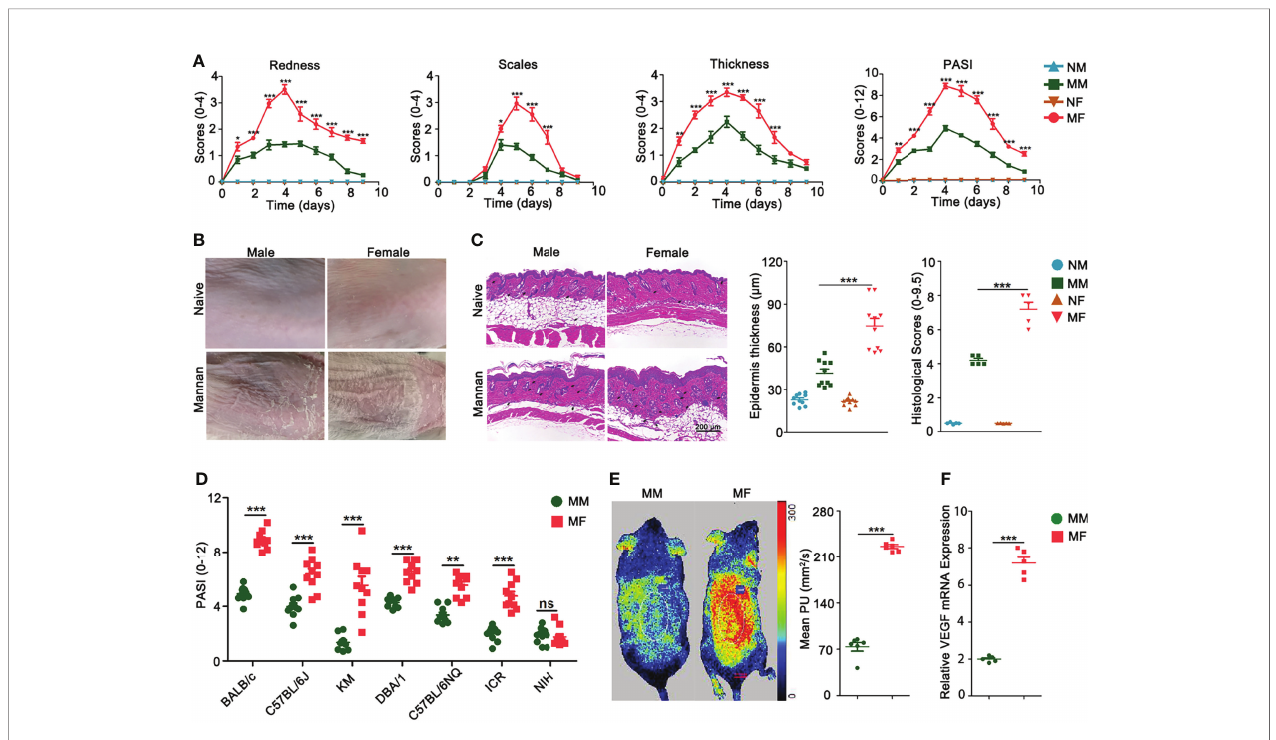
FIGURE 2 | Female mice developed more severe psoriasis. (A) Comparison of redness, scales, thickness, and total psoriasis area and severity index (PASI) between BALB/c female and male mice after mannan application (n = 15/group). (B) Representative pictures of psoriasis and naive skin from female and male mice on Day 5 (n = 12/group). (C) Comparison of H&E-stained skin sections, epidermal thickness, and histological scores between naive and psoriatic BALB/c female and male mice (n = 5/group). Scale bar: 200 m m. In fi ltration of immune cells is marked by black arrows. (D) Comparison of total PASI at the peak of psoriasis in BALB/c, C57BL/6J, KM, DBA/1, C57BL/6NQ, ICR, and NIH female and male mice on Day 5 (n = 10/group). (E) Blood fl ow (n = 6/group) and (F) VEGF gene expression (n = 5/group) in the psoriatic skin offemale and male mice on Day 5 after mannan application. Mean level of blood fl ow as well as VEGF gene expression in the PBS treated female and male mice was taken as one. Each experiment was repeated twice. Statistical analyses were performed using an unpaired t test and n indicates number of mice. The data represent mean ± SEM. NM, naive male; MM, Mannan + Male; NF, Naive Female; MF, Mannan + Female. ns, not signi fi cant; *p < 0.05; **p < 0.01. ***p <